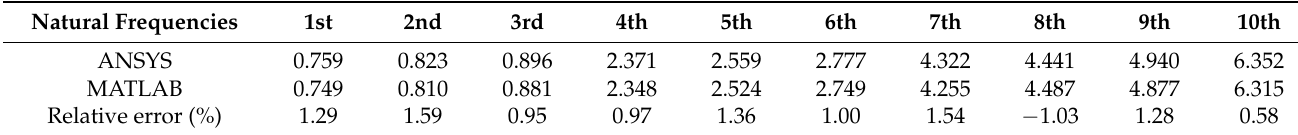
Table 1. Comparison of structural natural